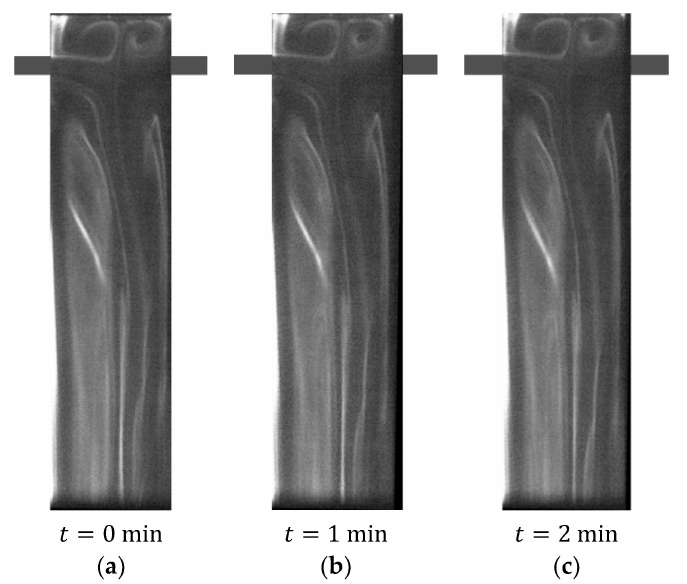
Figure 6. Three images obtained at different time instants with the AB-RPLIF method at Re = 50.